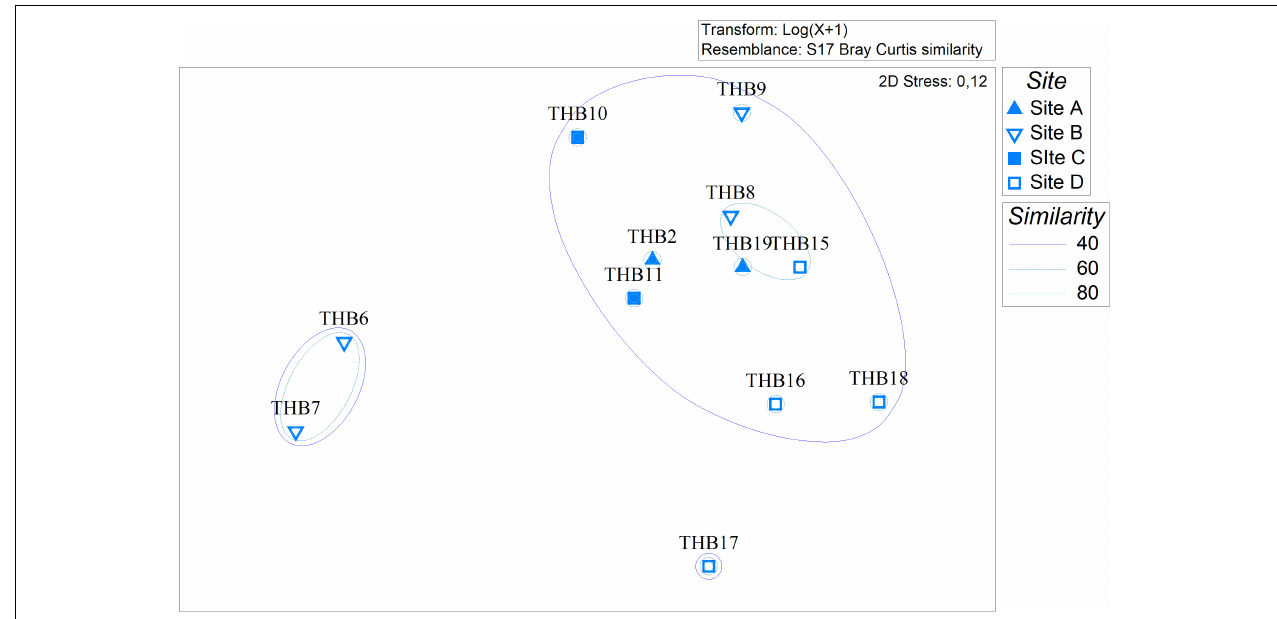
FIGURE 1 | Non-metric multidimensional scaling analysis (nMDS) computed on Bray-Curtis similarity values obtained for relative abundances of bacterial OTUs retrieved in sponge samples.